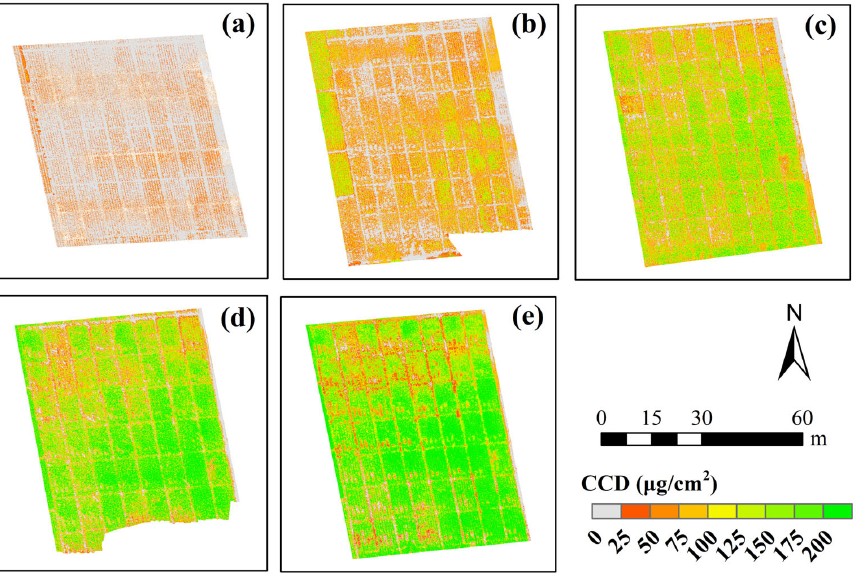
Figure 13. CCD mapping of UAV images, where ( a – e ) refers to the V6 − R1 growth stage, respec ‐ tively.